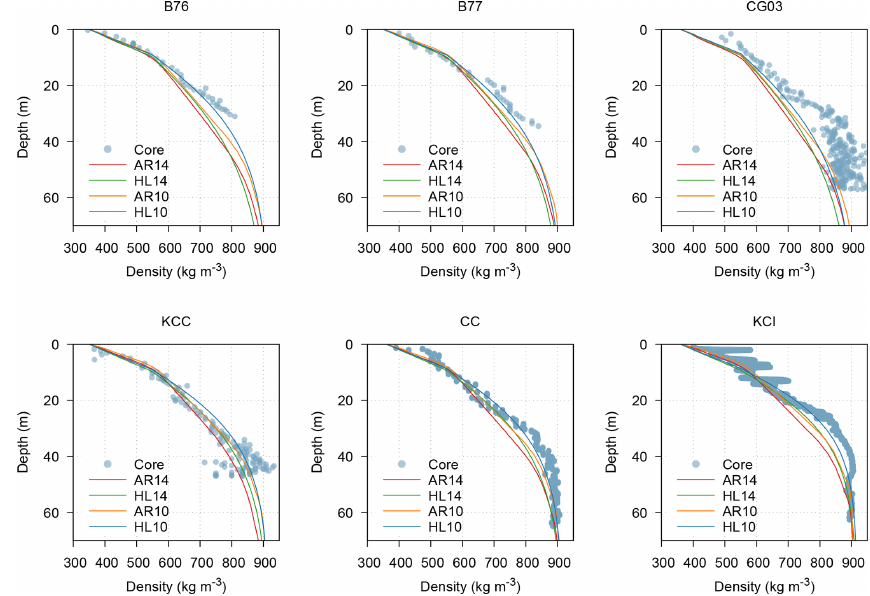
Figure 4. Observed and modelled depth–density profiles. Modelled profiles are obtained running Arnaud et al. (2000) (AR) and Herron and Langway (1980) (HL) in a steady-state condition. The numbers 14 and 10 stand for a mean annual firn temperature of − 14 and − 10 ◦ C, respectively.